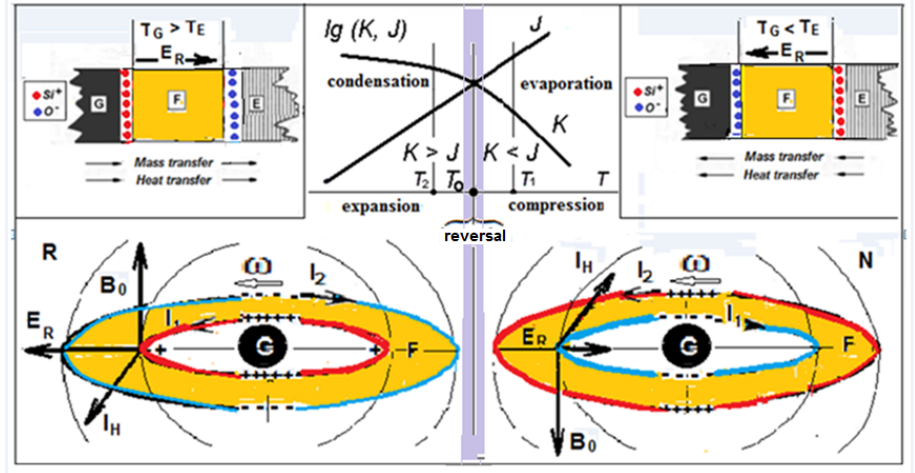
Fig. 5. Heat and mass transfer and charges separation in the F-layer. Left - the expansion mode (R), right - the compression mode (N). The formation of DEL and its daily rotation giving rise to the initial field B 0 . The interaction of B 0 with the radial electric field of the DEL E R generates the Hall current I H directed along the current producing the field B 0